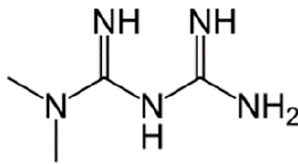
Figure 1. Chemical structure of metformin.